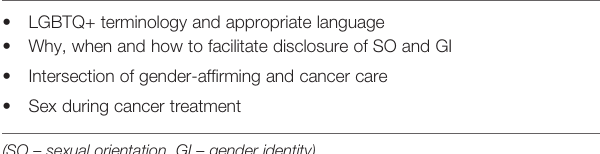
FIGURE 1 | Cycle of In fl uence for HCP-Patient Interactions in LGBTQ+ Cancer Care. This framework describes how knowledge, attitudes and behaviours of healthcare professionals (HCPs) may interact and provides a tool from which to plan interventions for HCP education and organisational change.